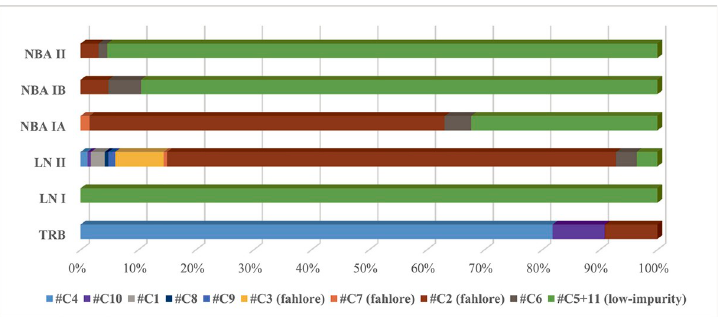
Fig 4. Distribution of the different copper types (clusters: For definition see text) in time. The largest variety in compositional groups is observed for the LN II period. In contrast, in the developed Bronze Age, NBA IB-II, only two different compositional types of low-impurity copper were used, and only minor amounts of fahlore